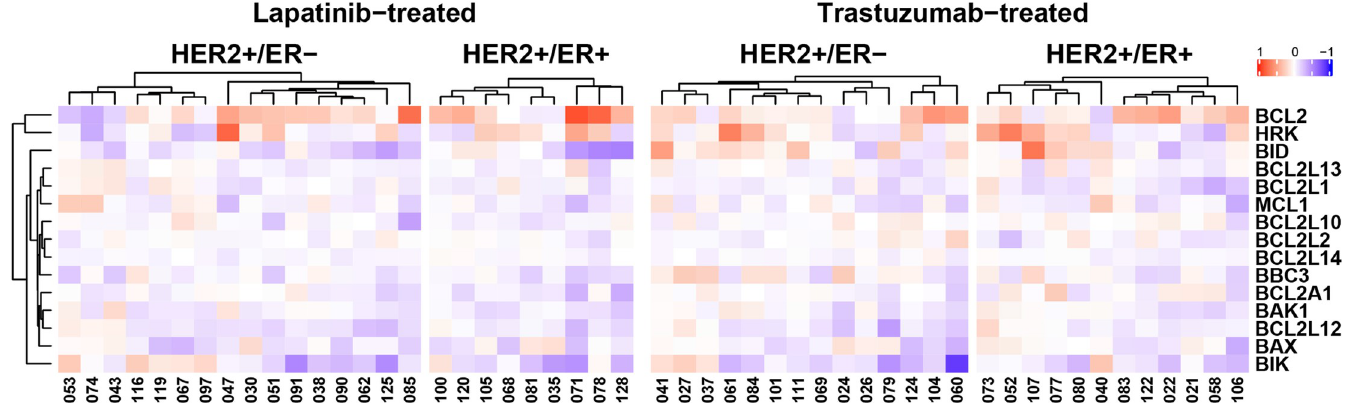
Fig 2. RNA-based analysis of BCL2 and other apoptotic regulatory genes. Heatmaps represent lapatinib-treated HER2+/ER- (n = 16) and HER2+/ER+ (n = 9) tumors, and trastuzumab-treated HER2+/ER- (n = 14) and HER2+/ER+ (n = 12) tumors. Each numerical identifier represents a clinical sample pair. Data are the log10 ratio of run-in (post-treatment) sample compared to paired baseline (pre-treatment) sample. Heatmaps include genes with statistically significant differences post- treatment. Heatmaps were generated with ComplexHeatmap (v2.4.3). Note, genes (proteins): BCL2 (BCL-2); HRK (HRK); BID (BID); BCL2L13 (BCL-rambo, MIL1); BCL2L1 (BCL-X L ); MCL1 (MCL-1); BCL2L10 (NRH, BCL-B); BCL2L2 (BCL-w); BCL2L14 (BCL-G); BBC3 (PUMA); BCL2A1 (A1); BAK1 (BAK); BCL2L12 (BPR); BAX (BAX); BIK (BIK, NBK).